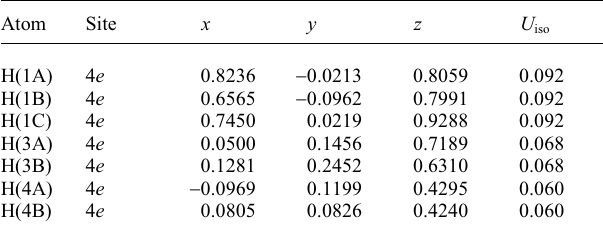
gen bonding interactions between C4 and S1. The distance be- tween C4 and S1 is 2.806(2)Å, and the angle C4–H4A–S1 is 106.980(2)°. Table 2. Atomic coordinates and displacement parameters (in Å 2 )